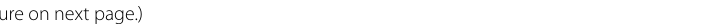
figure on next Fig. 2 a CT scan showing multiple cysts in the right kidney with peripheral hypoattenuation (orange arrow) characteristic of a hydatid cyst. b CT scan showing the typical “cyst within a cyst” appearance (orange arrow). c Anti—scolicidal agent (10% povidone–iodine) soaked mops (white arrow) isolating the hydatid kidney to prevent the spillage. d Numerous daughter cysts isolated from the excised kidney. e Pus mixed caseous material collected during aspiration (~ 2 Litres). f Scanner view showing the thick fibrotic pericyst (thick black arrow) compressing the native renal parenchyma at the periphery (thin black arrow). The intra-cystic material lies outside and shows the eosinophilic membrane (thin white arrow) corresponding to the ectocyst (hematoxylin and eosin, 20x). g Higher magnification of the thick fibrotic pericyst (black star) and the compressed native renal parenchyma. A compressed glomerulus is highlighted in the renal parenchyma (black arrow) (hematoxylin and eosin,